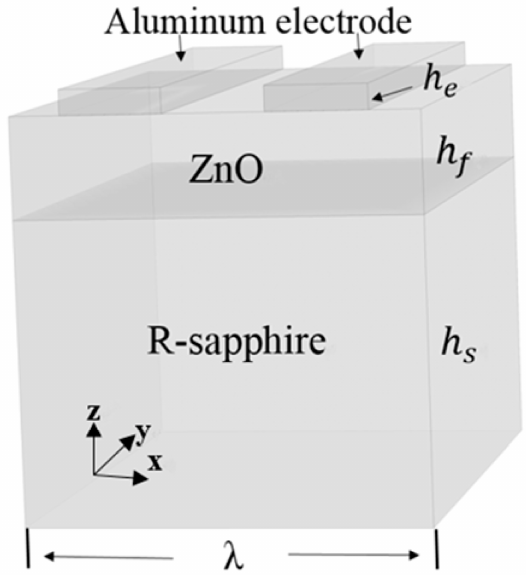
` ˘ 1120 ZnO/R-sapphire and